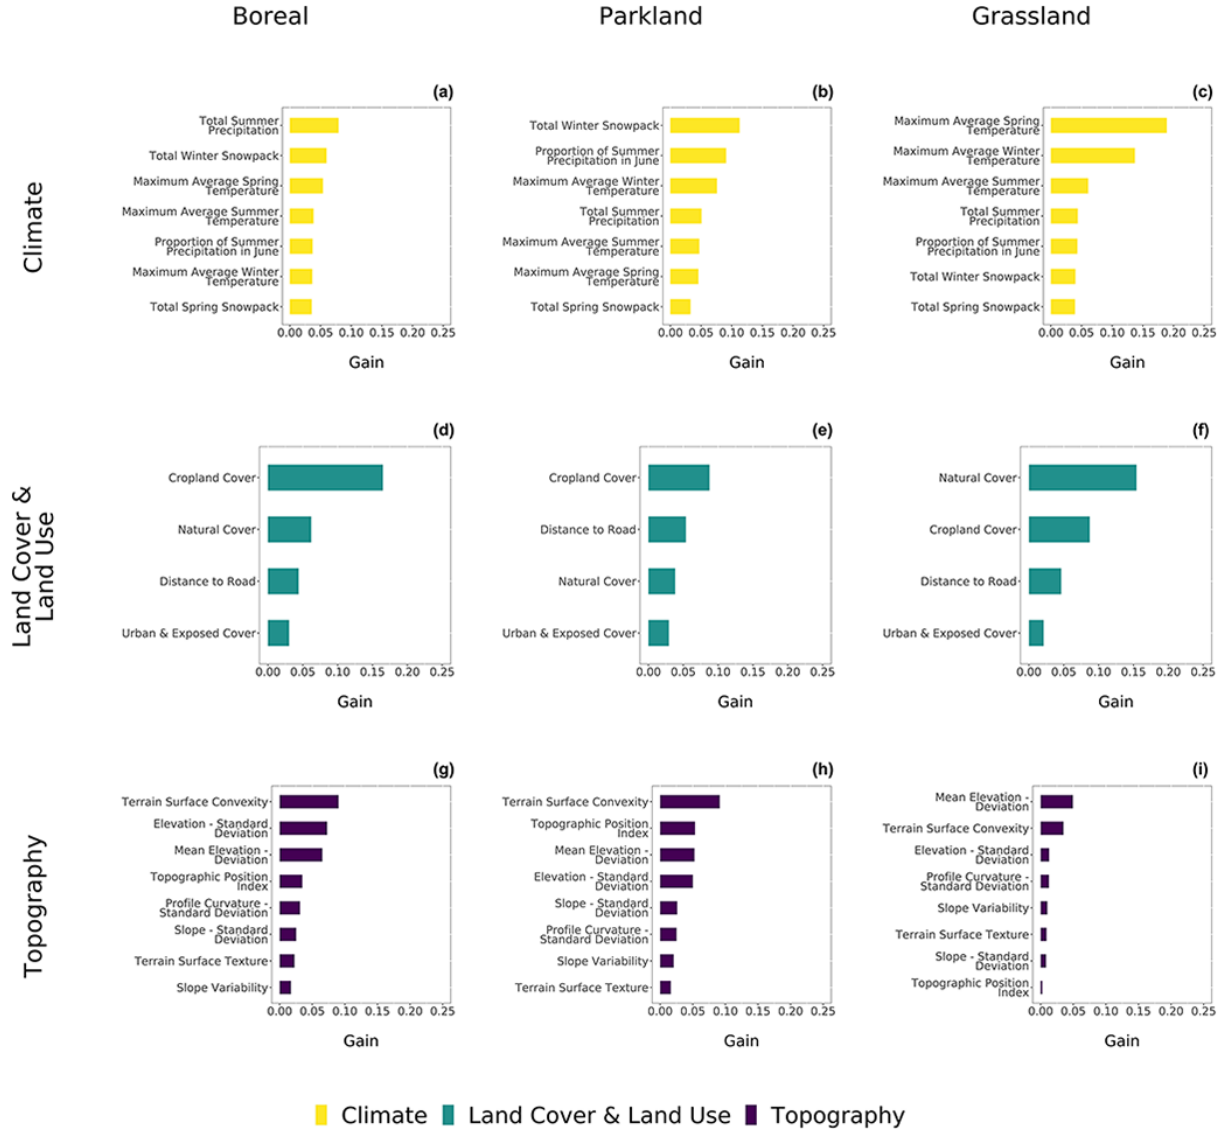
Figure 3. Variables ranked by their importance in the extreme gradient boosting models for wetlands delineated in the (1) Boreal Forest (totalling 12000 wetlands), (2) Parkland (totalling 12000 wetlands) and (3) Grassland (totalling 16000 wetlands) natural regions. These variables were proxies for climate (a–c) , land cover and land use (d–f) , and topography (g–i) . The gains illustrate the relative contribution of each variable in the model – the higher the value, the greater the